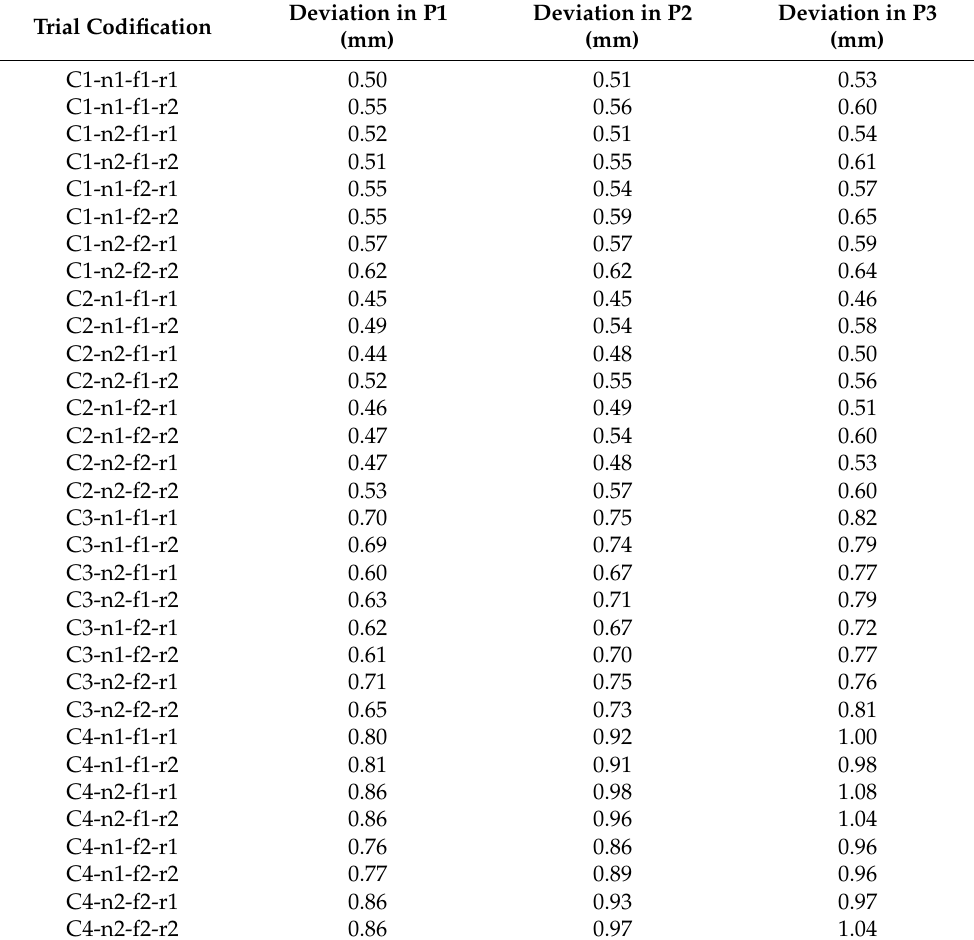
Table 3. Deviations in positions P1, P2 and P3 in all trials, reprinted with permission from ref. [5]. Trial